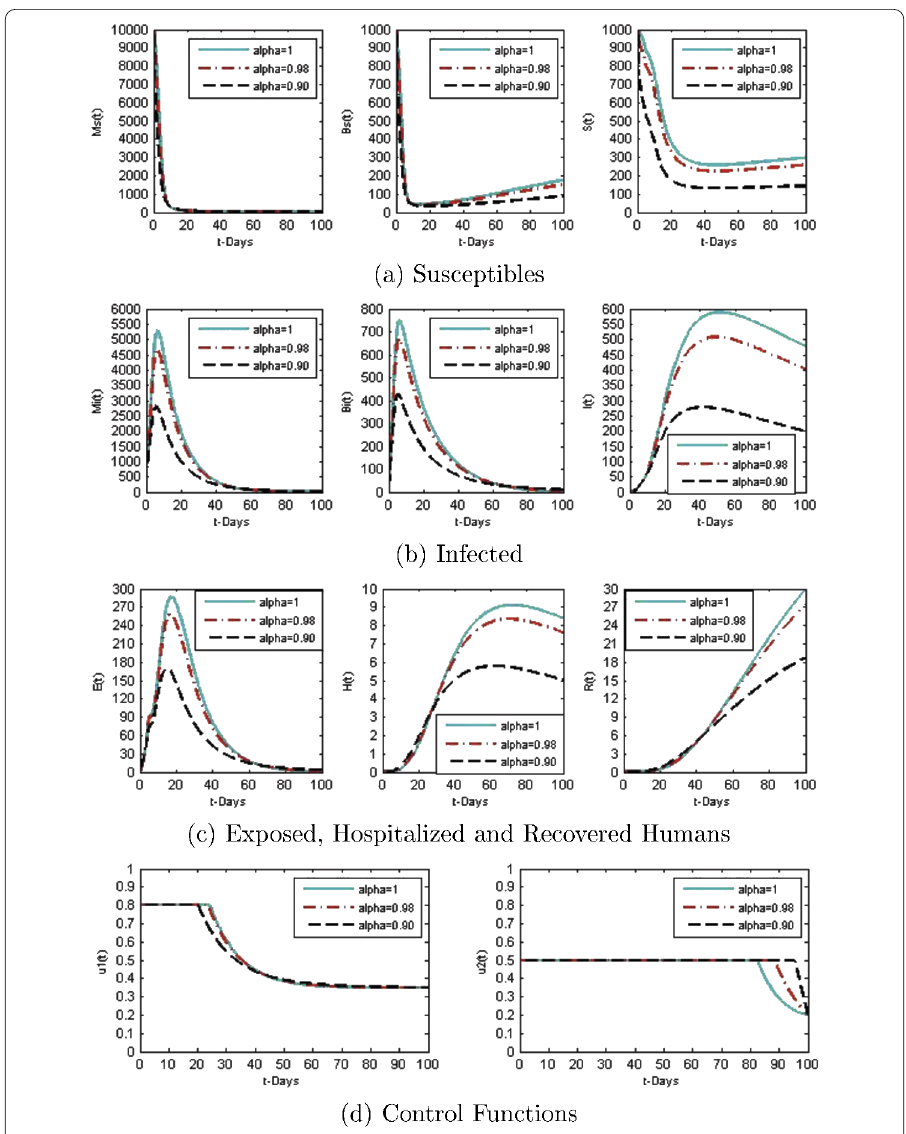
Figure 6 The approximate solutions of the fractional delay optimal control problem by using NSFDM. When 0 ≤ u 1 ≤ 0.8, 0 ≤ u 2 ≤ 0.5, with d = 5 and different α , and (cid:7) t =